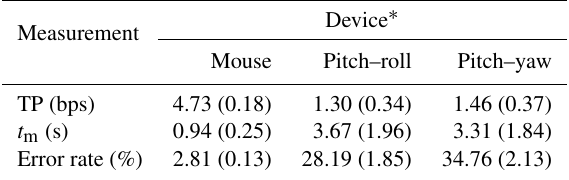
Table 3. Experiment